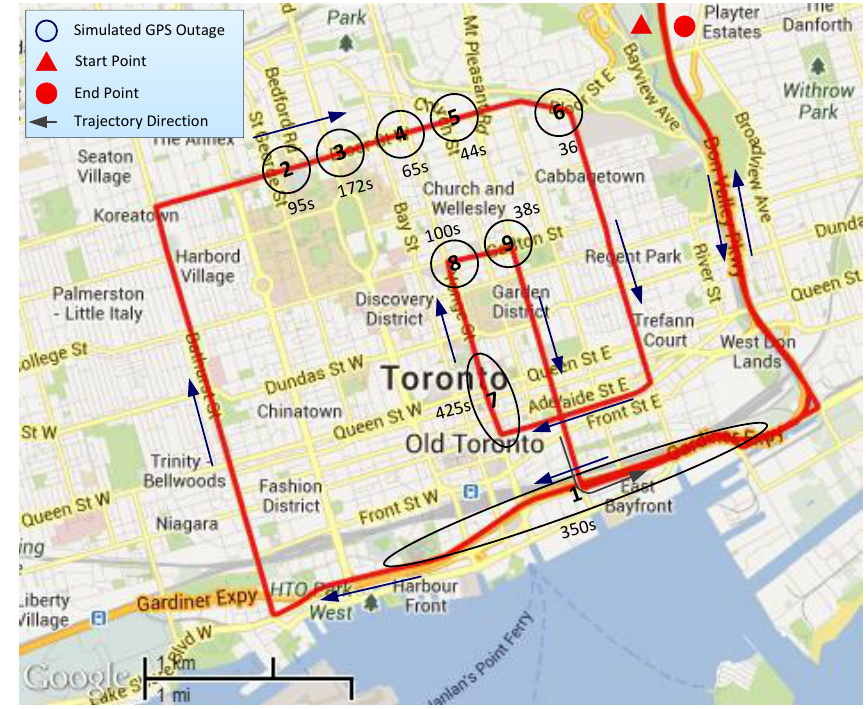
Figure 14. Main section of the test trajectory in downtown Toronto, ON,